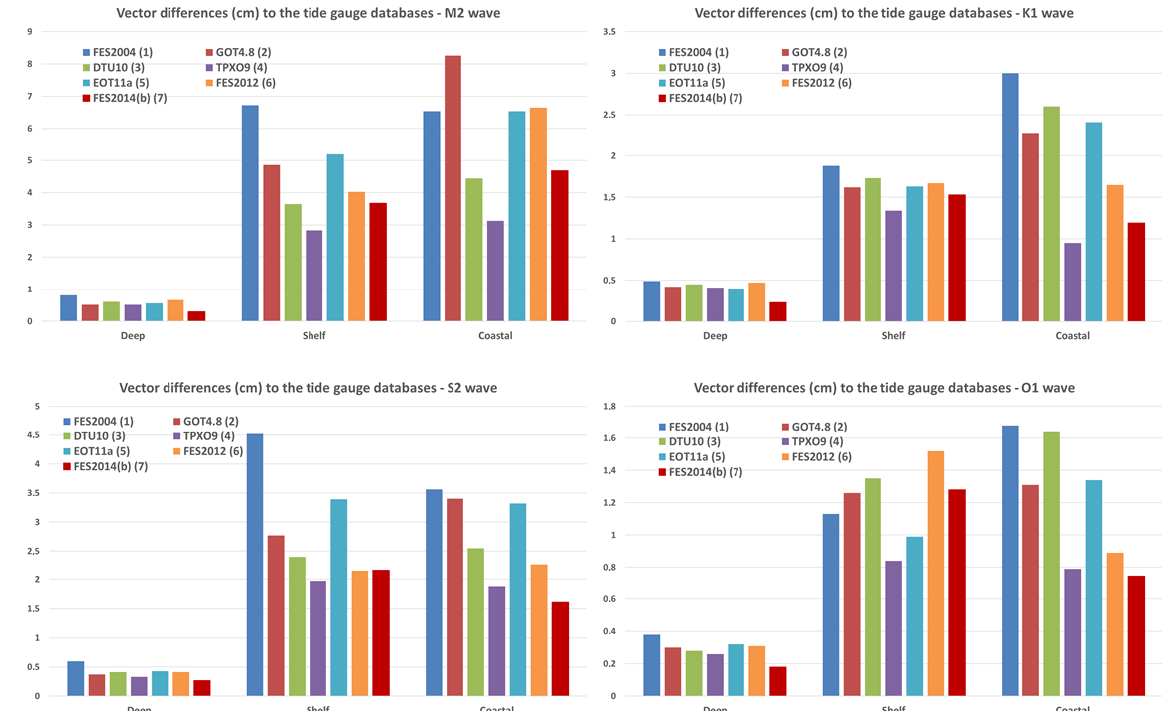
Figure 12. Vector differences (cm) between the TG databases and the global tidal models, for M2, K1, S2, and O1. The deep group is made of abyssal plain TGs; the shelf is made of tides gauges located in upper 500m depth limit. The coastal group is made of TGs collected in coastal databases such as